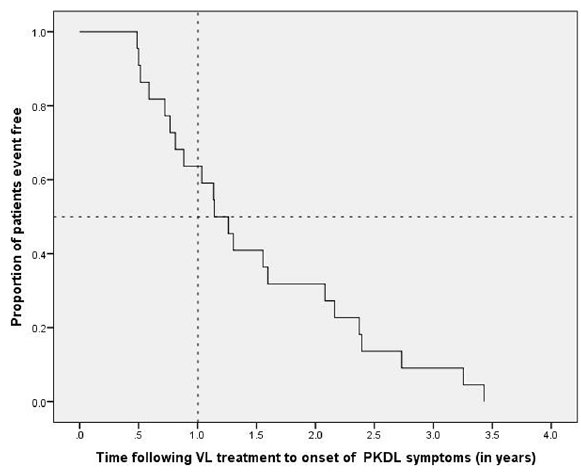
Figure 2. Uncensored Kaplan–Meier graph of time to develop- ing post Kala-azar dermal leishmaniasis (PKDL) lesions follow- ing treatment of visceral leishmaniasis (VL) with 20 mg/kg Ambisome.